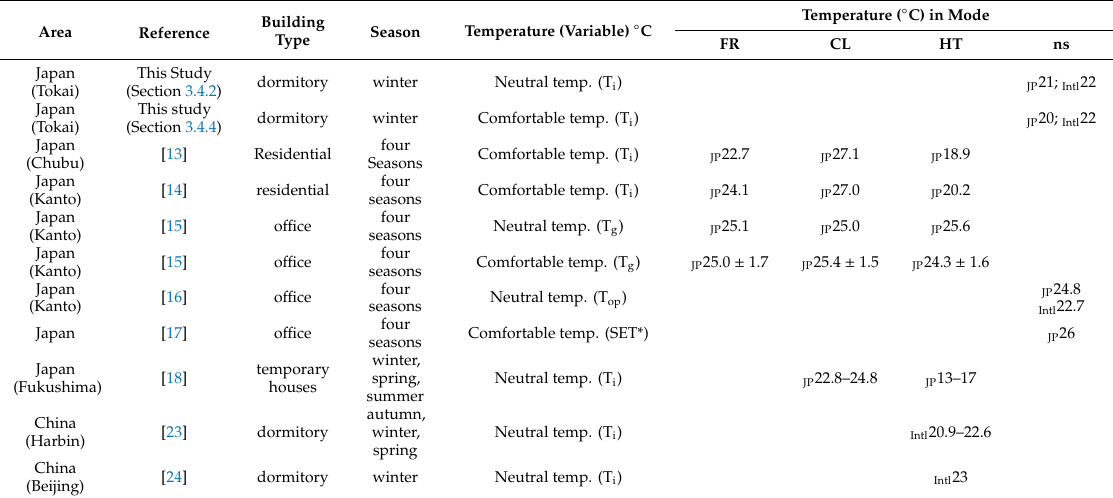
Table 12. Comparison with existing research in